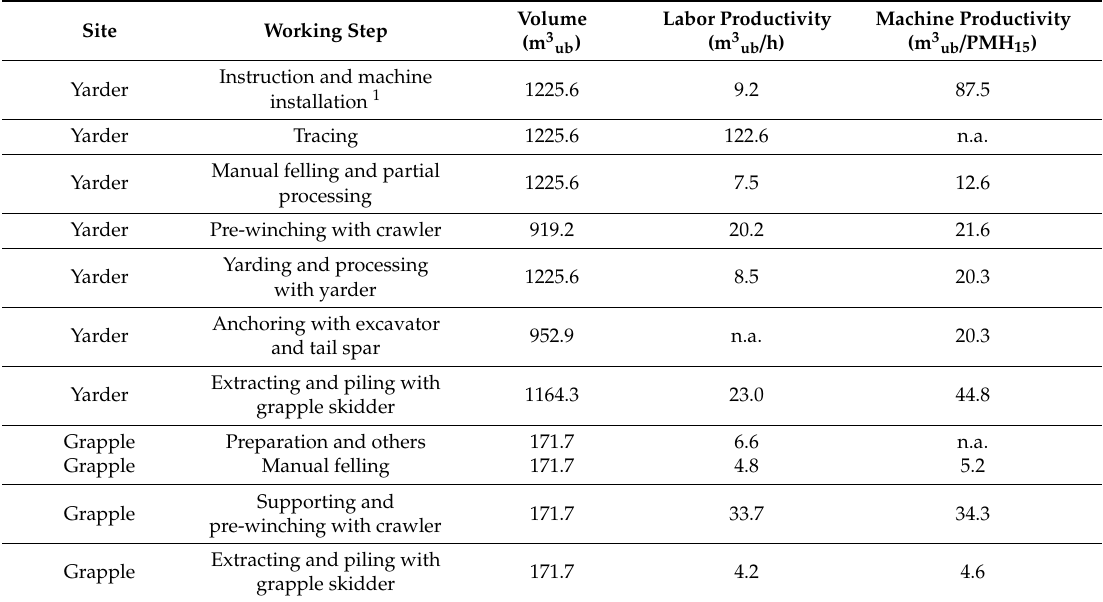
Table 5. Resulting productivity of the di ff erent working steps in the cable-based